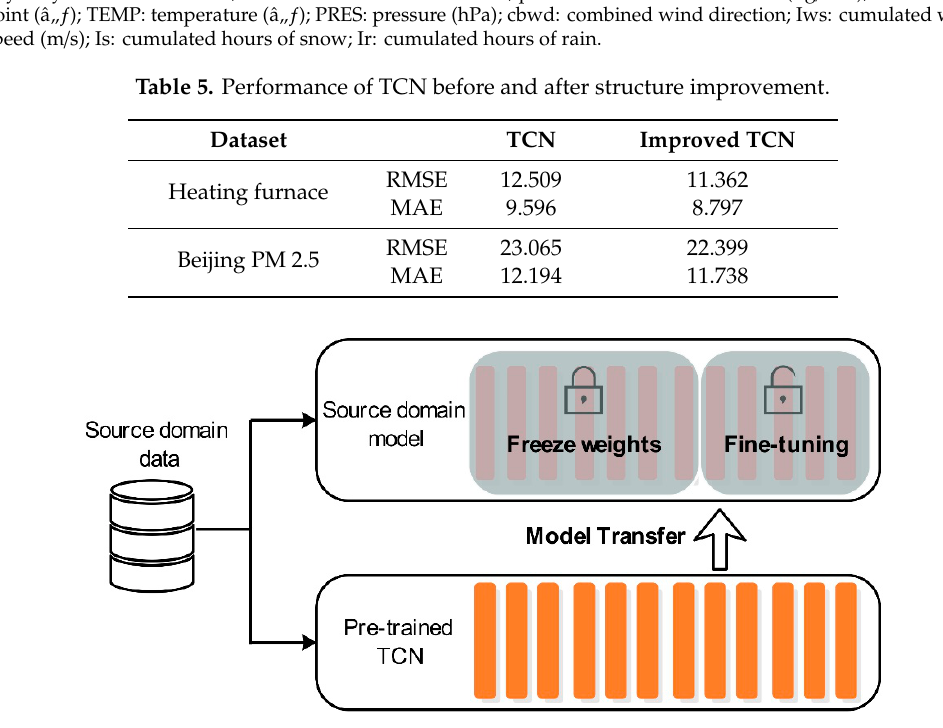
Figure 10. Using self-transfer learning as a method of neural network initialization. Some of the hidden layers of pre-training were frozen, and then the unfrozen layers were updated with their own training set.